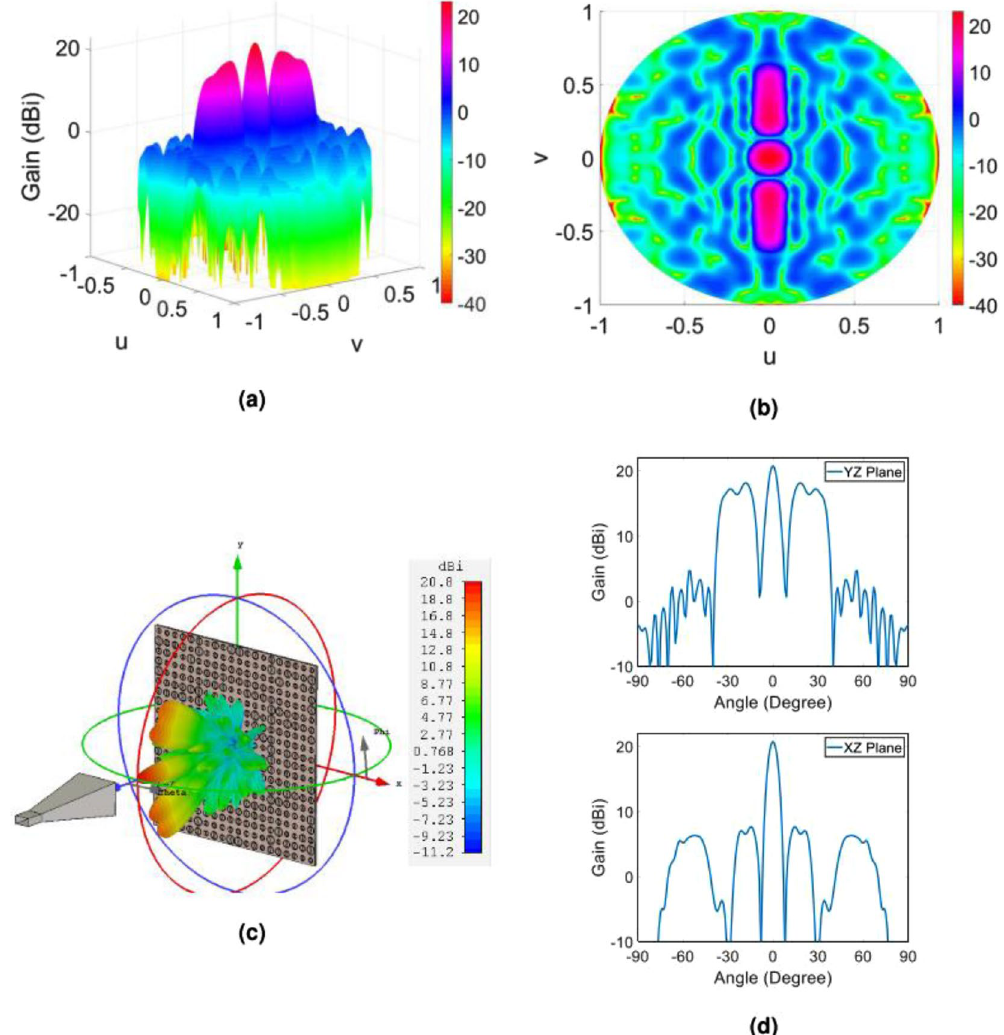
Figure 10. ( a ) Three-dimensional and ( b ) two-dimensional display of theoretical results of the object wave in the far field; ( c ) three-dimensional demonstration of the full wave simulation result of the object wave in CST software; ( d ) demonstration of the object wave in the two principal planes of the hologram. The principal planes in ( d ) are the YZ- and XZ-planes or u = 0 and v = 0,